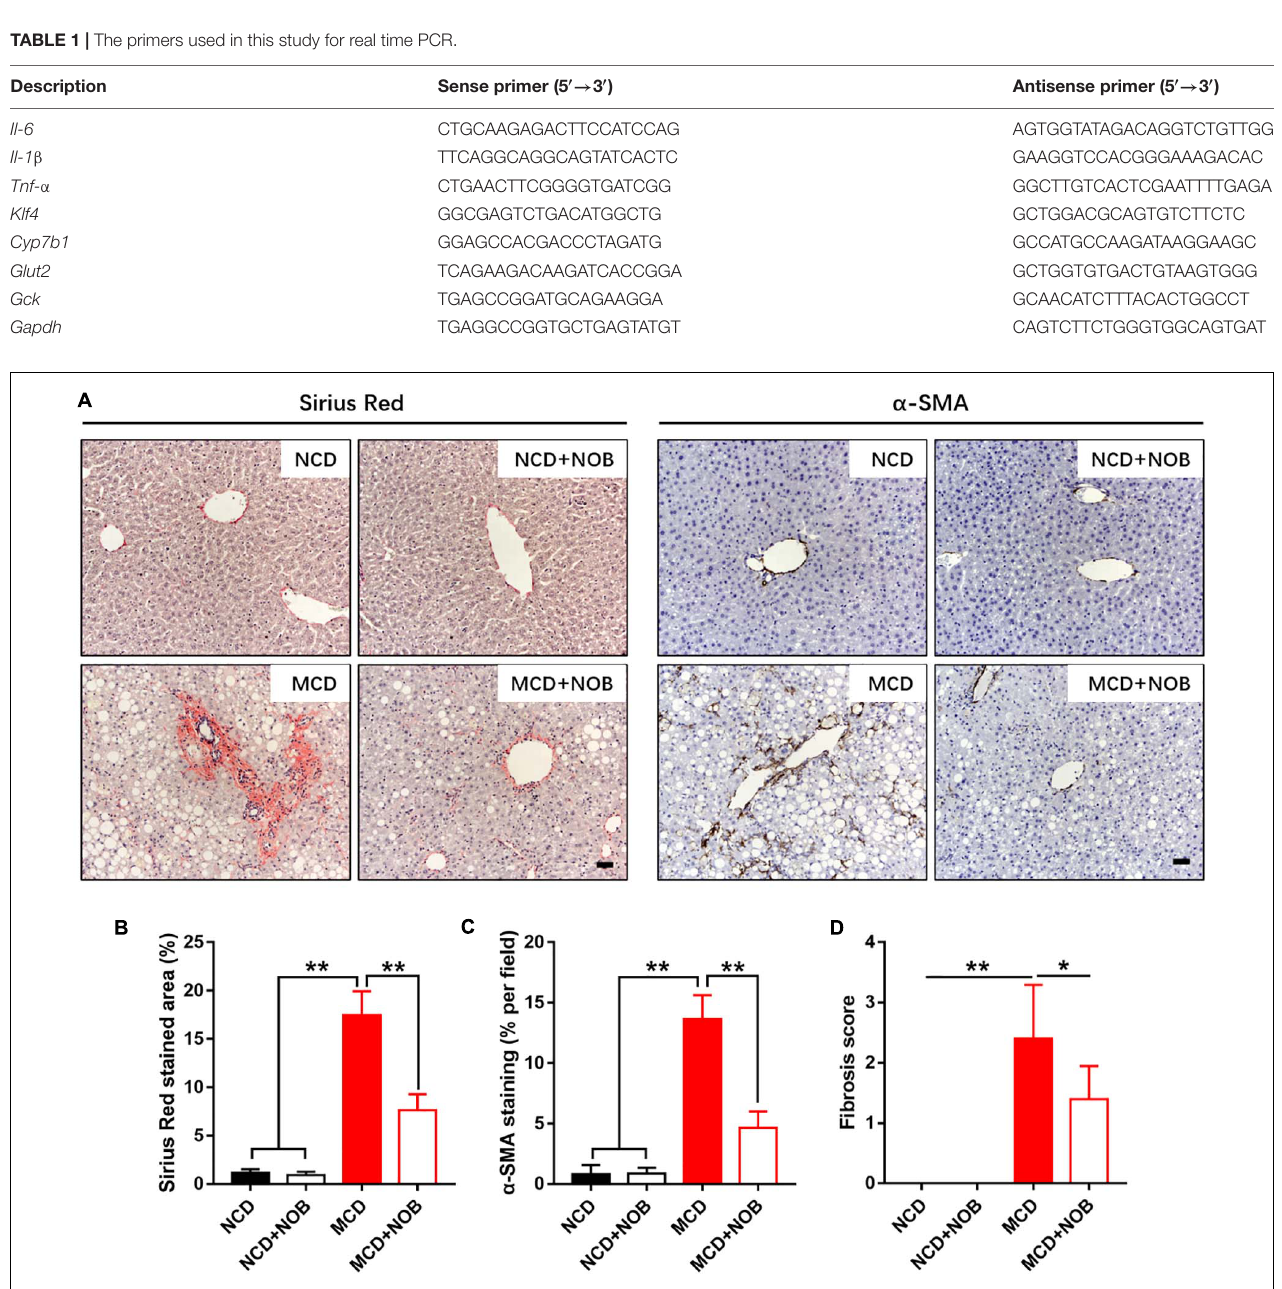
FIGURE 2 | The effect of NOB on liver fibrosis in MCD-induced mice. The deposited collagen and activated HSCs were shown by Sirius red and α -SMA staining, respectively. (A) The representative images of Sirius red staining and α -SMA immunohistochemical staining in liver from each group. Scale bar = 300 µ m. (B) Quantification and statistical analysis of sirius red-stained areas was shown. (C) Quantification and statistical analysis of α -SMA-stained areas was shown. (D) Quantification of fibrosis score was shown. Data were expressed as the mean ± SD ( n = 8). * P < 0.05, ** P < 0.01.